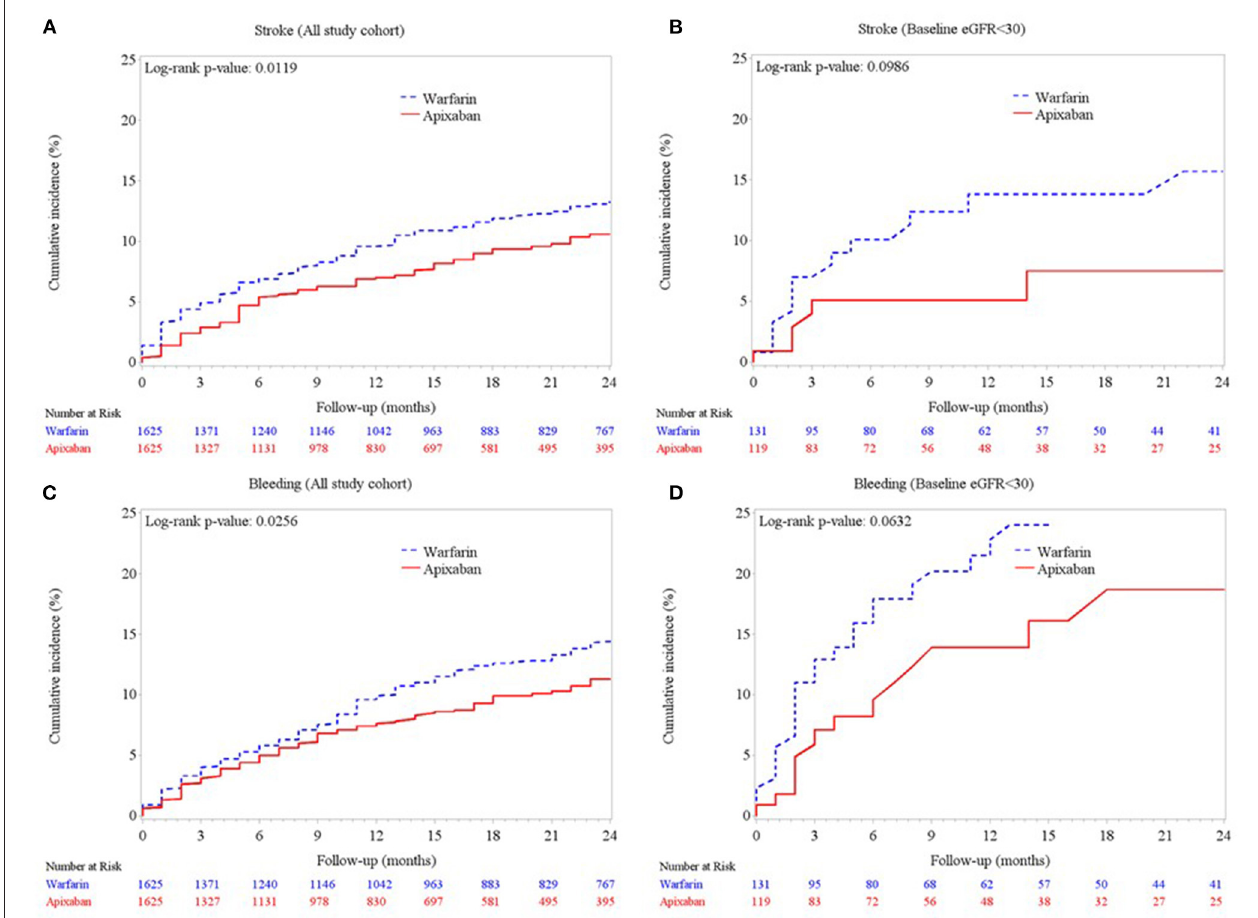
FIGURE 2 | Cumulative incidences of (A) ischemic stroke/systemic embolism in the matched cohort, (B) ischemic stroke/systemic embolism in the subgroup of patients with advanced CKD (eGFR < 30 ml/min/1.73 m 2 ), (C) major bleeding in the matched cohort, and (D) major bleeding in the subgroup of patients with eGFR < 30 ml/min/1.73 m 2